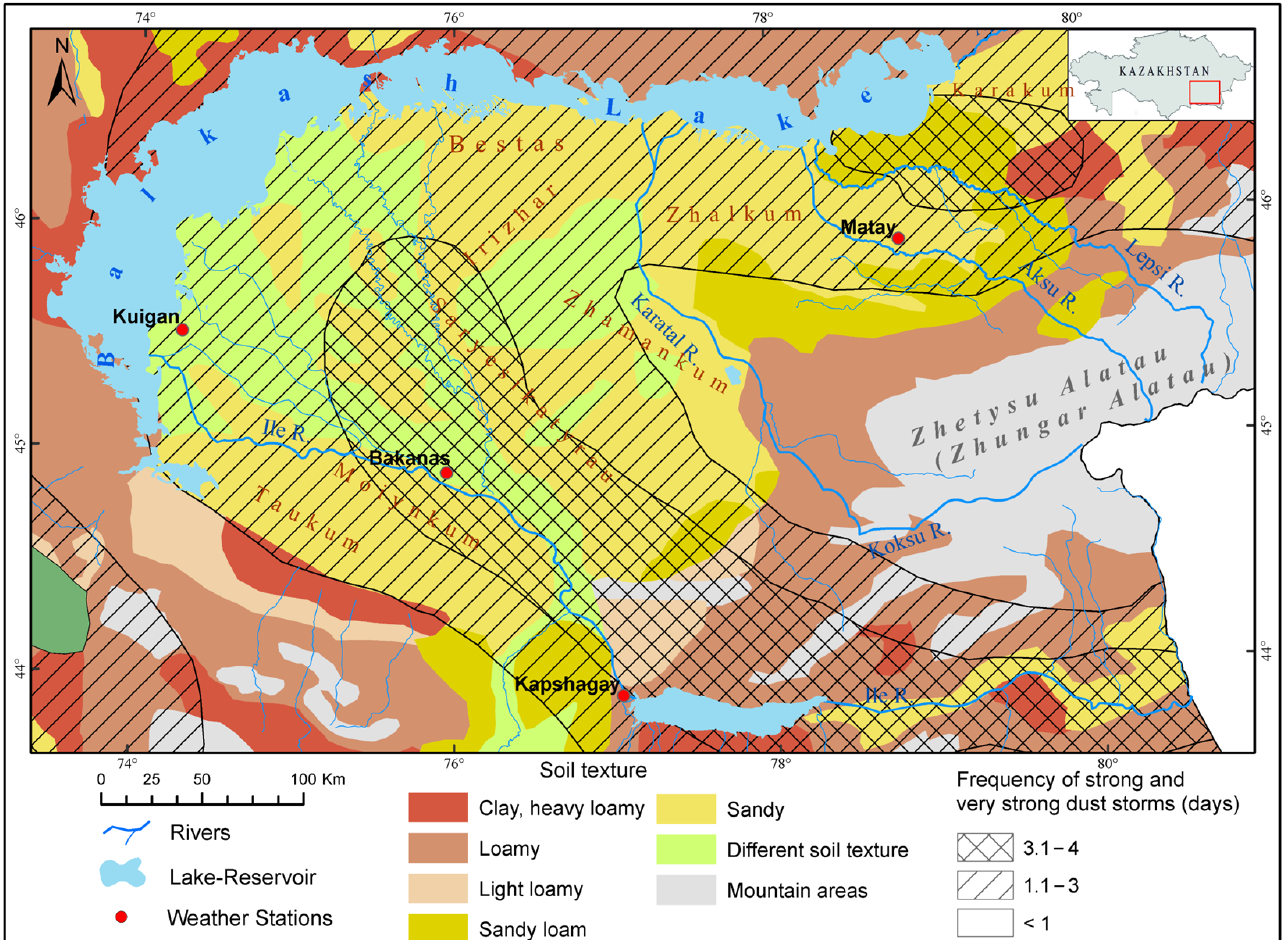
Figure 6. The relationship between the origin of strong and very strong dust storms and soil texture. Soil texture is a critical soil feature defining the soil surface’s resistance to wind erosion or soil deflation. Soil textures include lightly and heavily loamy, loamy, sandy loam,